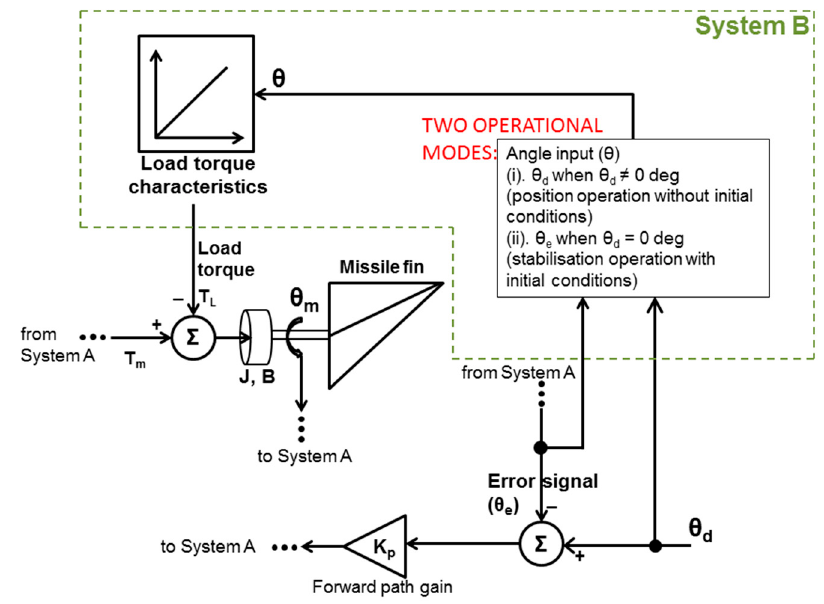
Figure 6. System B Figure 6. System B model.